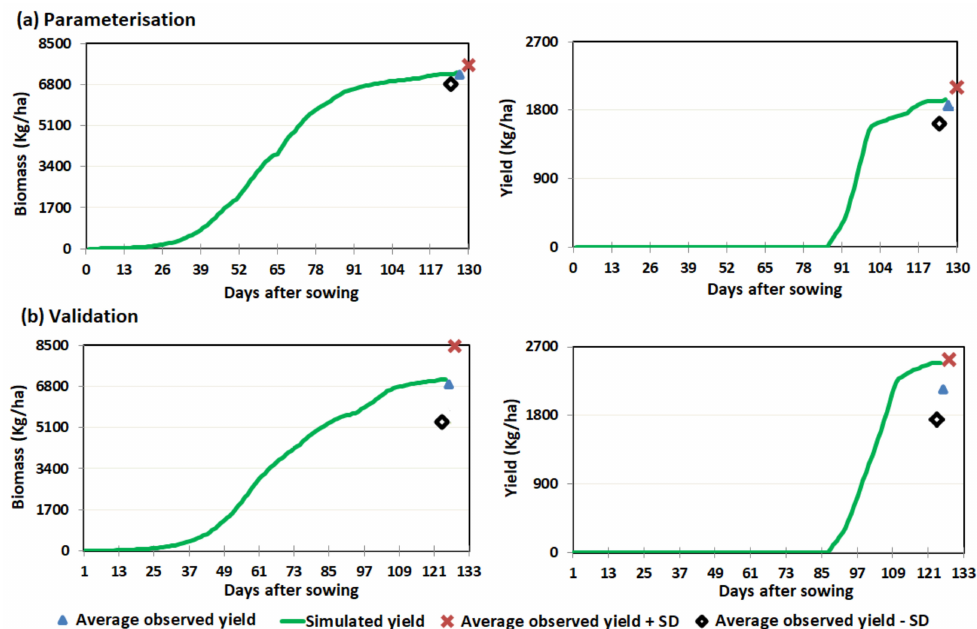
Figure 4. Observed (points) and simulated (lines) biomass and grain yield for the parameterisation and validation. SD = standard deviation.